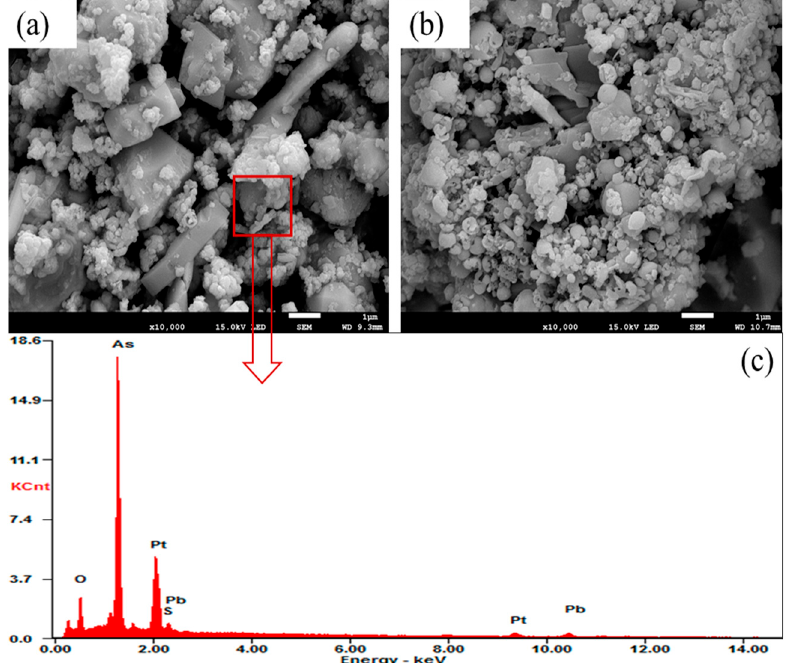
Figure 6. SEM analysis of the leaching residues obtained at different acid concentrations: ( a ) 120 g/L, ( b ) 140 g/L and ( c ) EDS analysis of the leaching residue obtained at acid concentration of 120g/L.